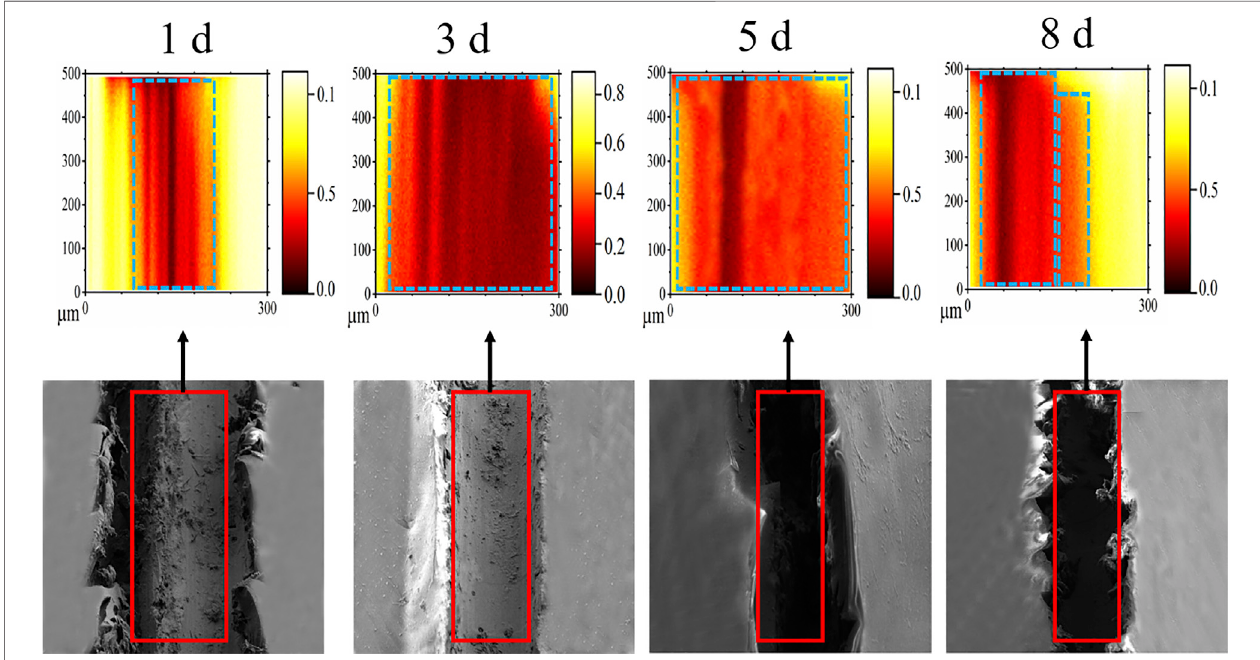
Frontiers in Materials |